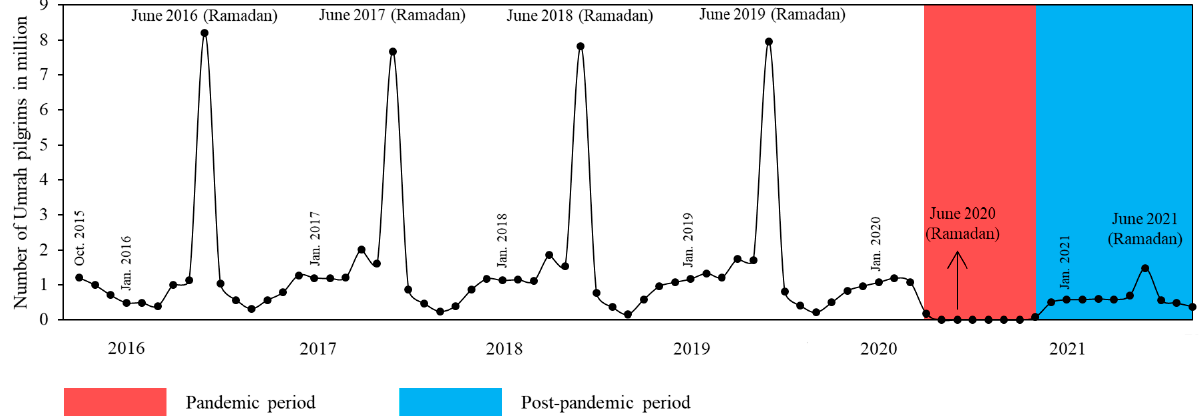
Figure 9. Monthly temporal profile of Umrah pilgrims from October 2015 to September 2021 (source: [43]).